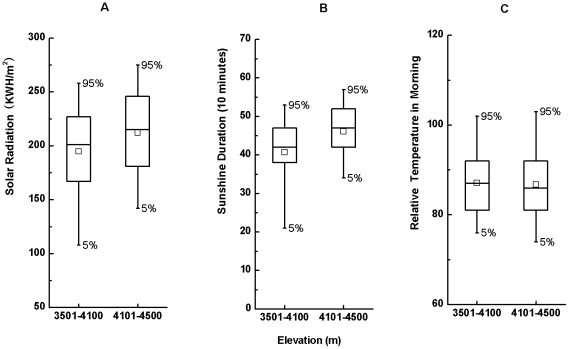
Mean radiation (A) and duration (B) of sunlight, and relative temperature (C) across the winter range (4101–4500 m) and non-winter range (3500–4100 m).Horizontal lines represent medians and quartiles; boxes represent means.